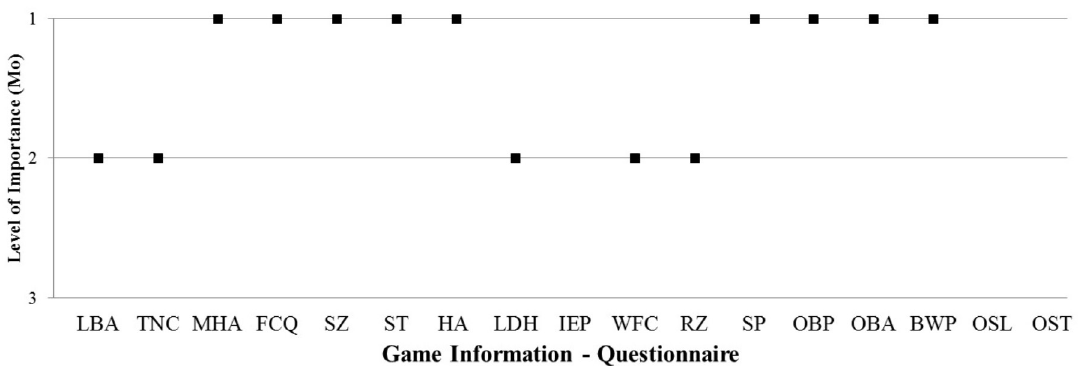
Figure 2: Mode values of each of the game information faced by the setters during the Attack Processes contained in the questionnaire. Where: Last Ball Attacked (LBA); Team’s Net Composition (TNC); Middle-Hitter’s Availability (MHA); First Contact Quality - Pass (FCQ); Setting Zone (SZ); Setting Technique (ST); Hitters’ Availability (HA); Longest Distance Hitter (LDH); Infiltration/Exchange Position (IEP); Who Made the First Contact - Pass (WFC); Reception Zone - pass (RZ); Set Period (SP); Opponent Team’s Blocking Tactic - Positioning (OBP); Opponent Team’s Blocking Tactic - Anticipation (OBA); Blocking Weak Point (BWP); Opponent Team’s Serve Location (OSL); Opponent Team’s Serve Type (OST). Source: The author.